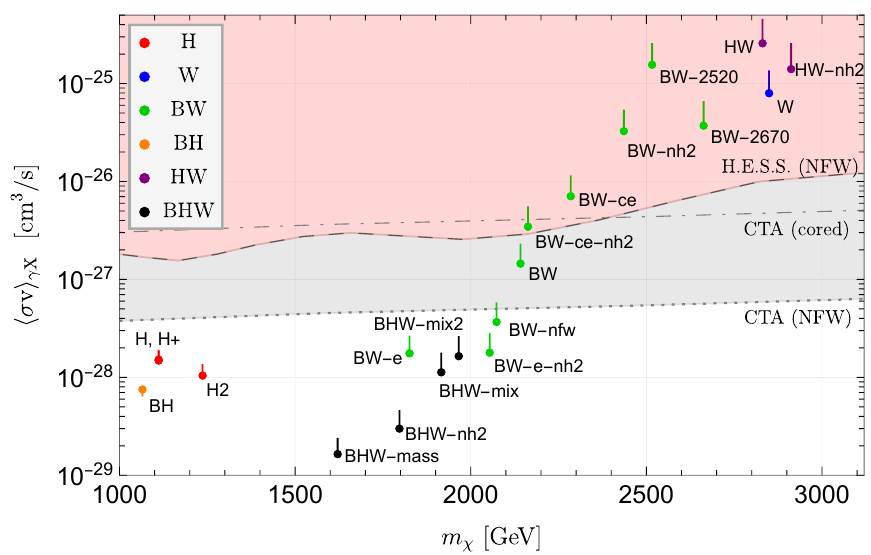
Figure 2 . h σv rel i SE+NLL (dots) and resummation effect (attached vertical lines) plotted γX